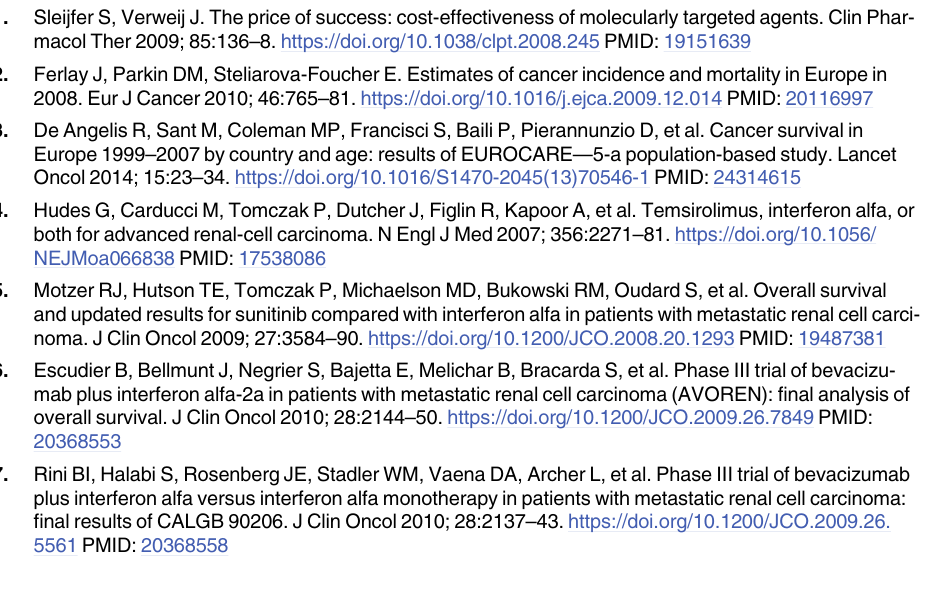
S3 Fig. Comparison of time to event 1 (i.e., time from diagnosis to second-line treatment or death) between original and simulated data. S4 Fig. Comparison of time to event 2 (i.e., time from start of second-line treatment to death) between original and simulated data. S5 Fig. Comparison of overall survival (i.e., time from diagnosis to death) between original and simulated